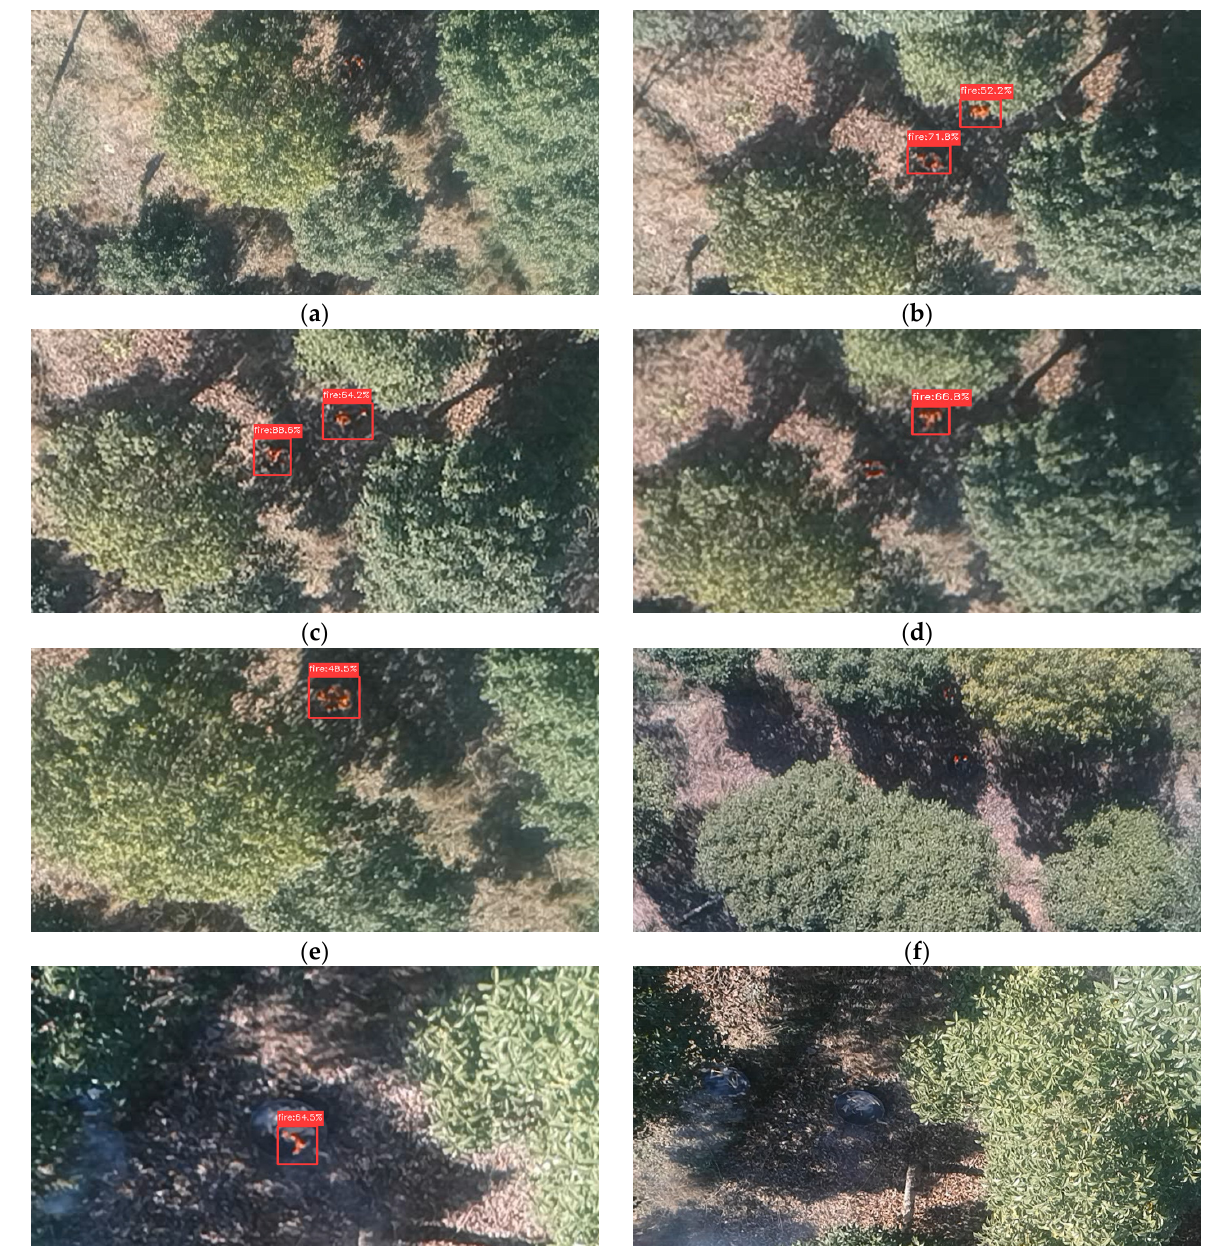
Figure 14. Some frame fragments selected from the saved detection video. ( a ) Frame No.112 with one missed object; ( b ) Frame No.130 with two detection objects; ( c ) Frame No.132 with two detection objects; ( d ) Frame No.167 with one missed object and one detection object; ( e ) Frame No.242 with one detection object; ( f ) Frame No.510 with two missed objects; ( g ) Frame No.576 with one detection object; and ( h ) Frame No.598 with an extinguished flame.